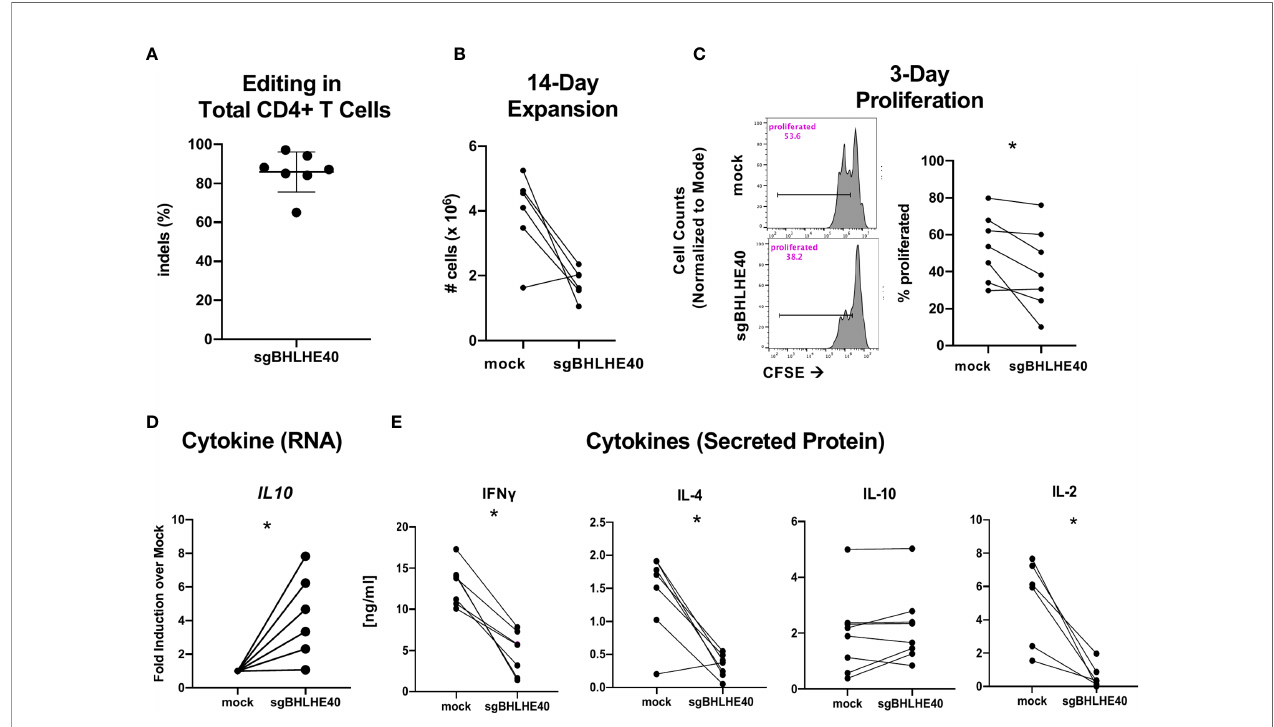
FIGURE 5 | BHLHE40 knockout leads to a reduction in IFN- g and IL-4 expression. (A) High knockout ef fi ciency in total CD4 + T cells. (B) In vitro expansion. After 2, 14-day stimulations with Immunocult, cells were collected and counted with an automated cell counter. (C) Representative fl ow cytometry histogram of CFSE dilution 3 days post a CD3/ a CD28 Dynabead stimulation. Gated on live singlets (left). Cumulative CFSE proliferation data of all samples (right). (D) Cytokine gene expression. IL10 expression 6 hours after stimulation with a CD3/ a CD28 Dynabeads. Expression is normalized to the house keeping gene, RPLPO . n = 6. (E) Cytokine Protein Secretion. T cells were stimulated with plate-bound a CD3 and soluble a CD28 and supernatant was collected at 24h (IL-2) and 48h (IFN- g , IL-4, IL-10) to measure cytokines by ELISA. n = 7, *p value < 0.05, Wilcoxon matched-pairs signed rank